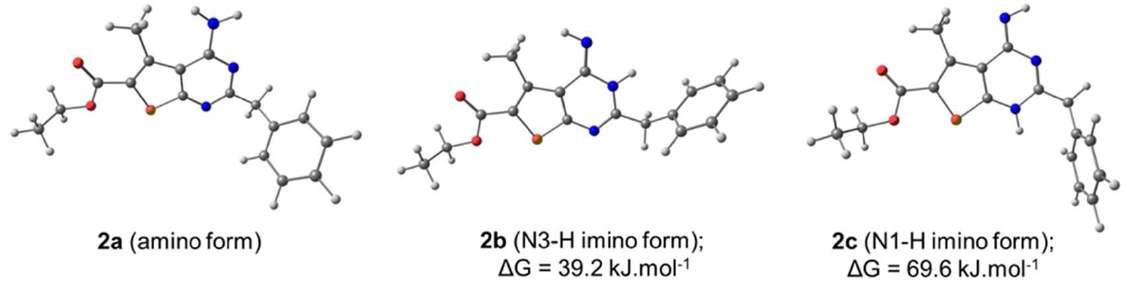
Figure 3. Tautomeric forms of compound 2 .